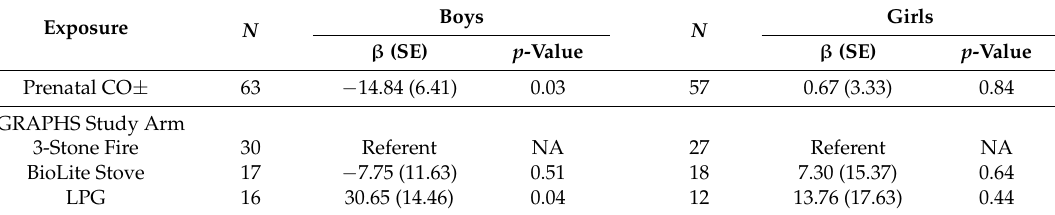
Table 3. Sex-stratified associations between prenatal carbon monoxide (CO) exposure and GRAPHS study arm on cord blood mononuclear cell mitochondrial DNA copy number (mtDNAcn) percentage *: Linear regression